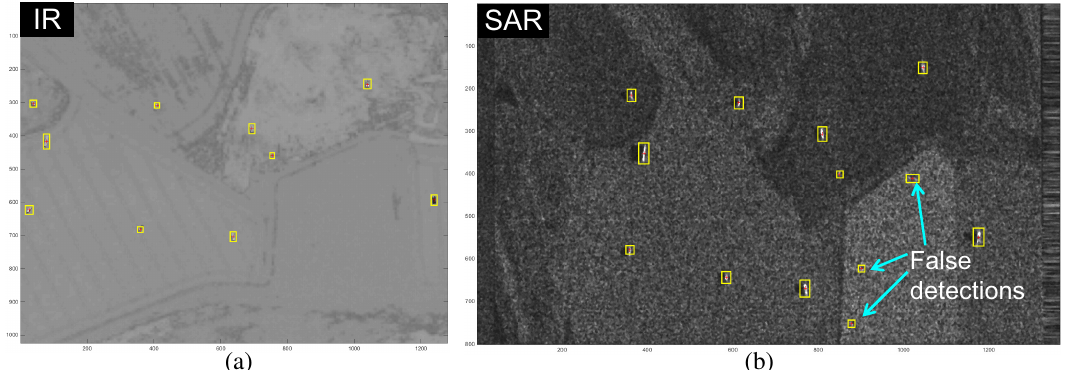
Figure 13. modBMVT-based initial target detection including the target centers: ( a ) IR target detection (BG2-T10-IR); ( b ) SAR target detection (BG2-T10-SAR). The code, BG2-T10-IR/SAR, denotes (background type-number of targets-sensor